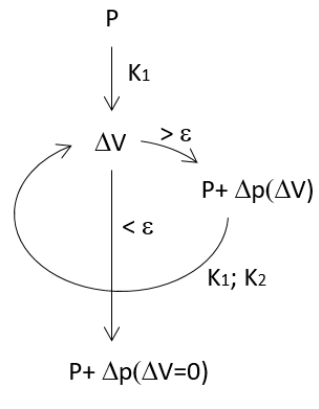
Fig. 7 Workflow of iterative